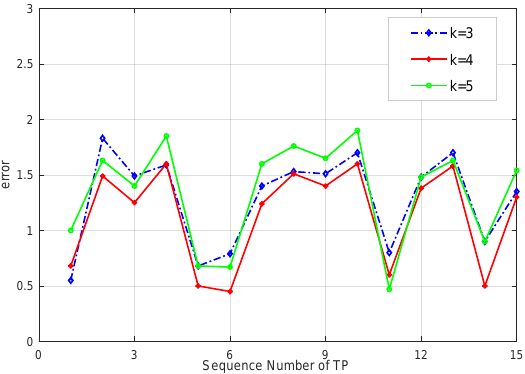
Figure 6. Positioning errors of WKNN algorithm under different K